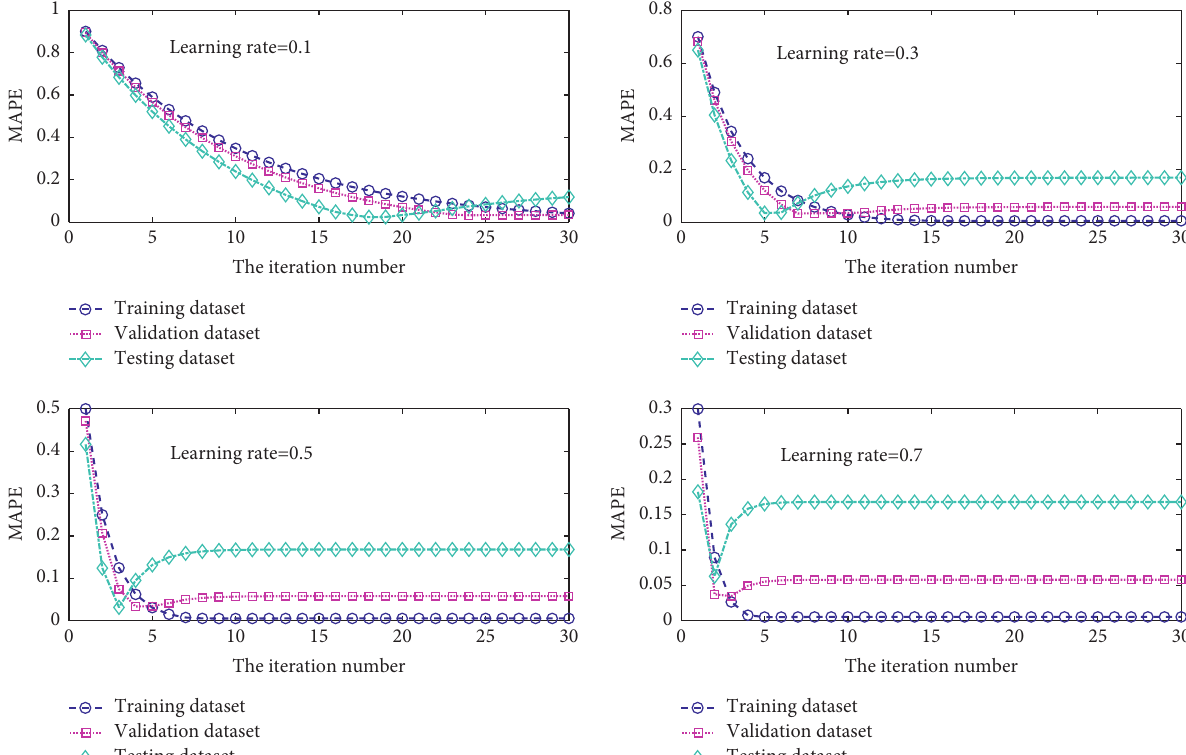
Figure 3: The cumulative loss of training dataset, validation dataset, and testing dataset with 4 different learning